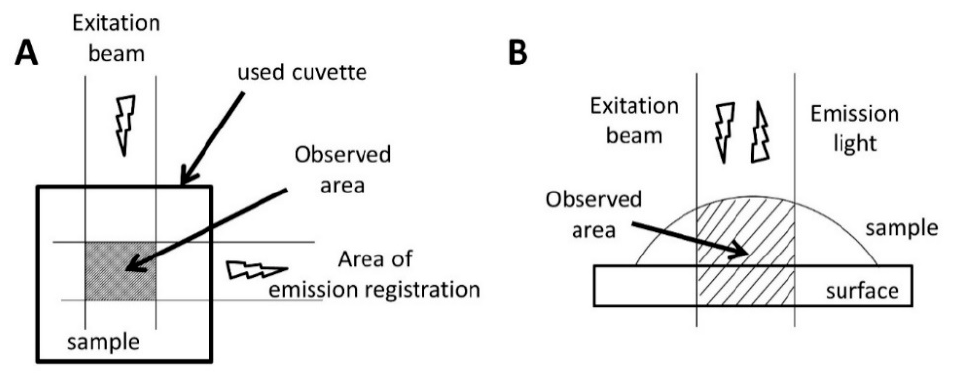
Figure 2. Scheme of fluorescence research in the standard version ( A ) and the fluorescence study on the surface ( B ). Again, the observed areas are shaded.